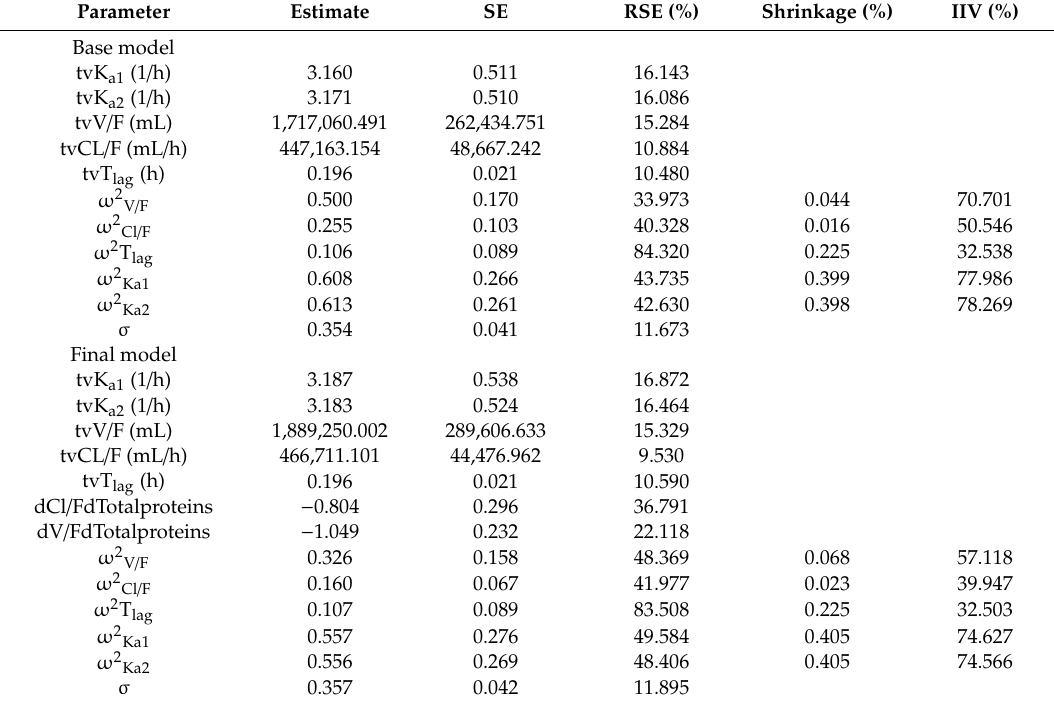
Table 6. Population pharmacokinetic parameters for tiropramide in base model and final model.